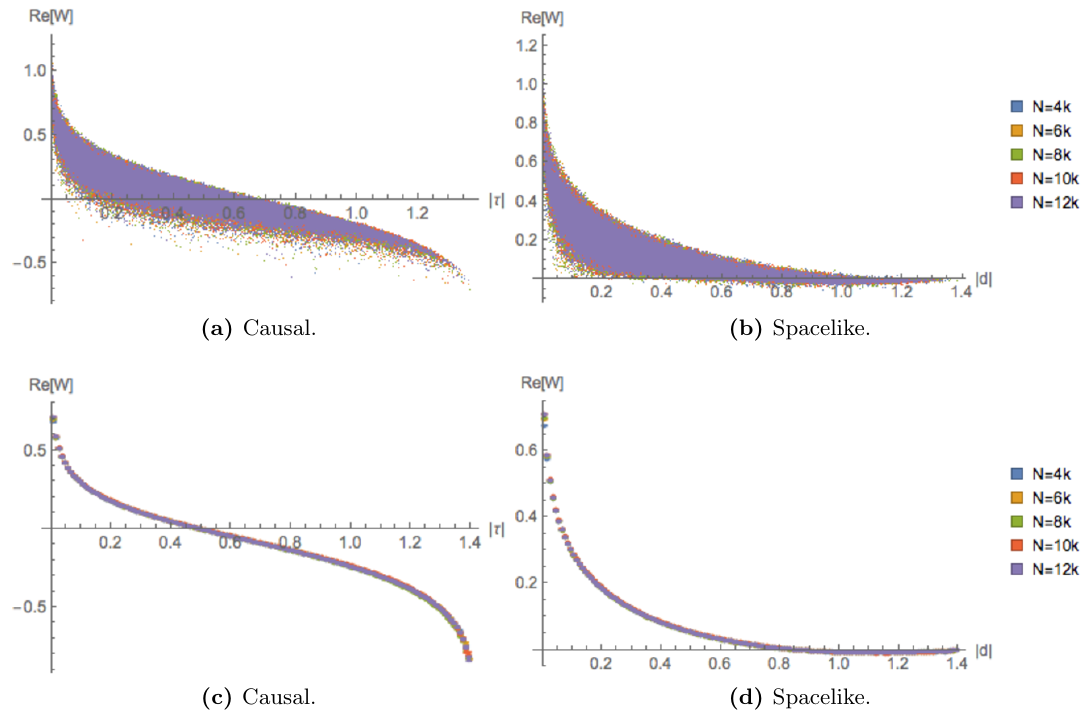
Figure 3. (a)-(b) represent Re[ W pairs, in the 2d causal diamond; m = 0. (c)-(d) are plots of the binned and averaged data with the